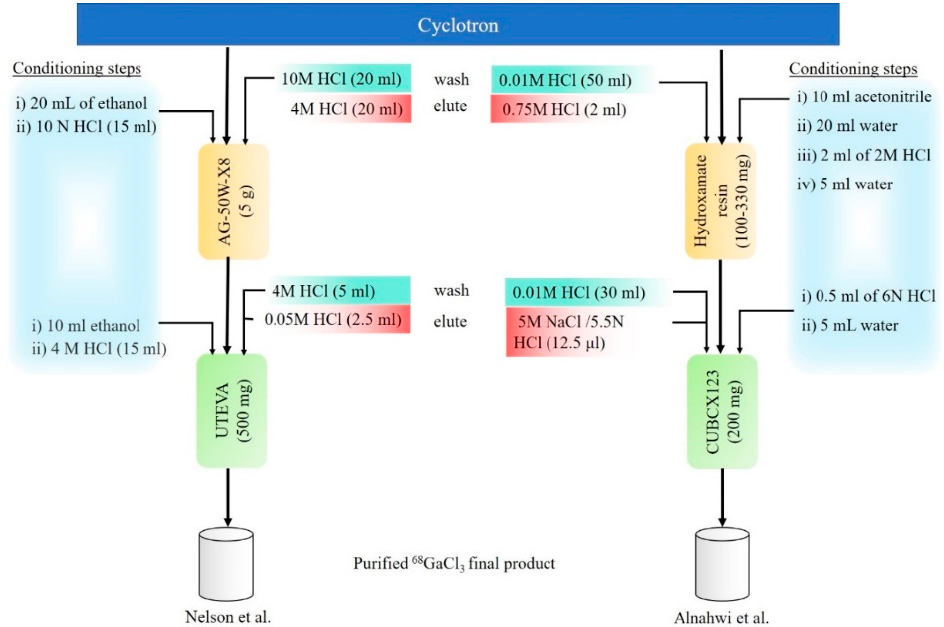
Figure 3. Summary of the steps in the purification of 68 Ga from TR-24 and TR-19 cyclotron [27,33]. The dissolution of a solid target from works using a GE PETtrace cyclotron is pre- sented in Table 4. Thisgaard and co-workers heated concentrated HCl to 90 °C using the QIS Dissolution System to dissolve the target [32]. In contrast, Siikanen and group [34] dissolved the foil target in 9.5 M HCl for 2 min, the fastest of all methods in this review. Studies using single-column purification indicated respectable yields for peptide radio- labeling, which took less than 45 min [38,46]. The single-column strategy purifies 68 Ga, separates 68 Zn, and finally formulates to [ 68 Ga]GaCl 3 in 0.05 M HCl using octanol-based TK400 resin. Before elution, the column was washed with 0.7 mL of 0.05 M HCl to remove acid residues from 7 M HCl that could affect the [ 68 Ga]GaCl 3 eluate. The final volume and concentration of [ 68 Ga]GaCl 3 were 3.5 mL in 0.05 M HCl, corresponding to the generator